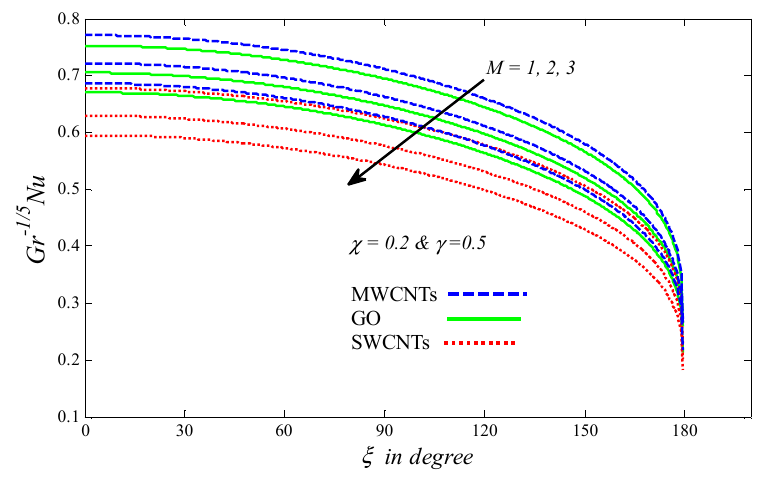
− Figure 13. Impact of M on Gr − 1/5 Nu